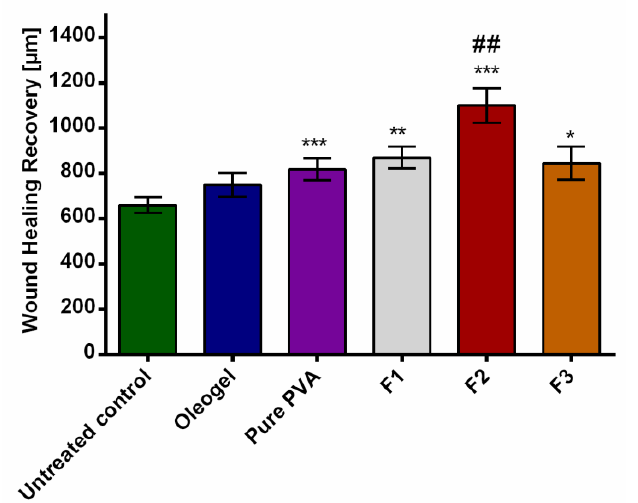
Figure 7. Wound healing recovery. * statistically significant, * p < 0.05; ** p < 0.01; *** p < 0.001 vs. untreated control and ## compared to TE-oleogel.